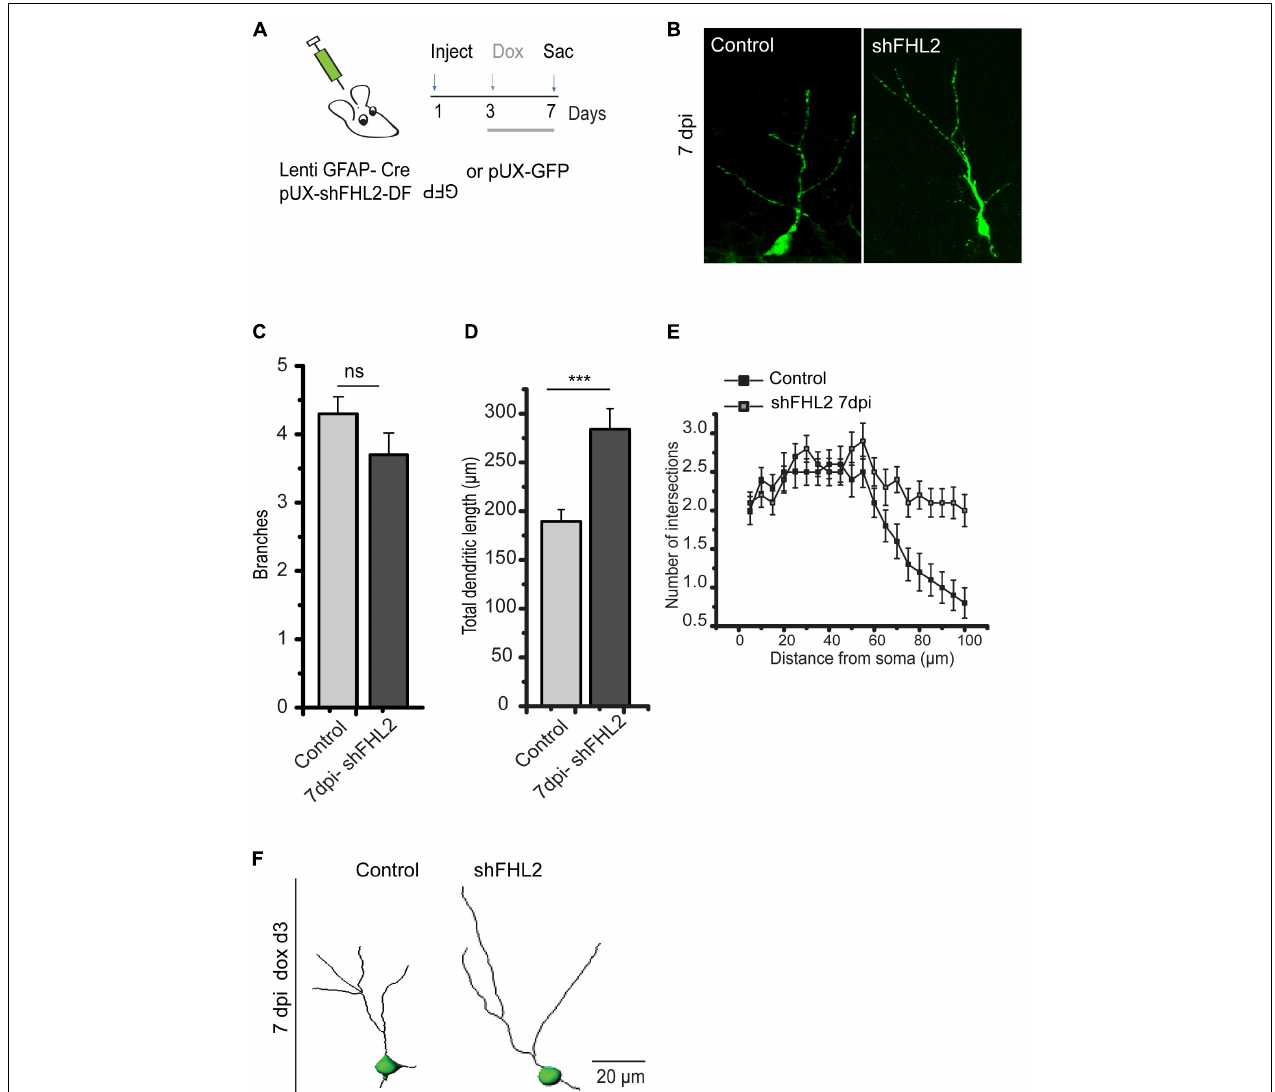
FIGURE 5 | Silencing of FHL2 increases adult-born DGC dendritic length during early development. (A) Experimental timeline of inducible FHL2 down-regulation with doxycycline induction (dox) at 3 dpi and sacrifice (sac) at 7 dpi. (B) Representative images of GFP control (GFP con) and shFHL2-expressing DGCs at 7 dpi induced at 3 dpi. Scale bar, 10 µ m. (C) Quantification of the number of dendritic branches in GFP con and shFHL2-expressing DGCs at 7 dpi. Two-tailed unpaired t -test, p > 0.05. (D) Quantification of total dendrite length for GFP-only expressing control and shFHL2 cells at 7 dpi. Two-tailed unpaired t -test, at 7 dpi, p < 0.05. (E) Sholl analysis at 7 dpi. Two-way ANOVA F (1, 56) = 925.96, p < 0.001. (F) Representative dendritic tracing of control cells and shFHL2 expressing cells dox induced d3 at 7 dpi, scale bar, 20 µ